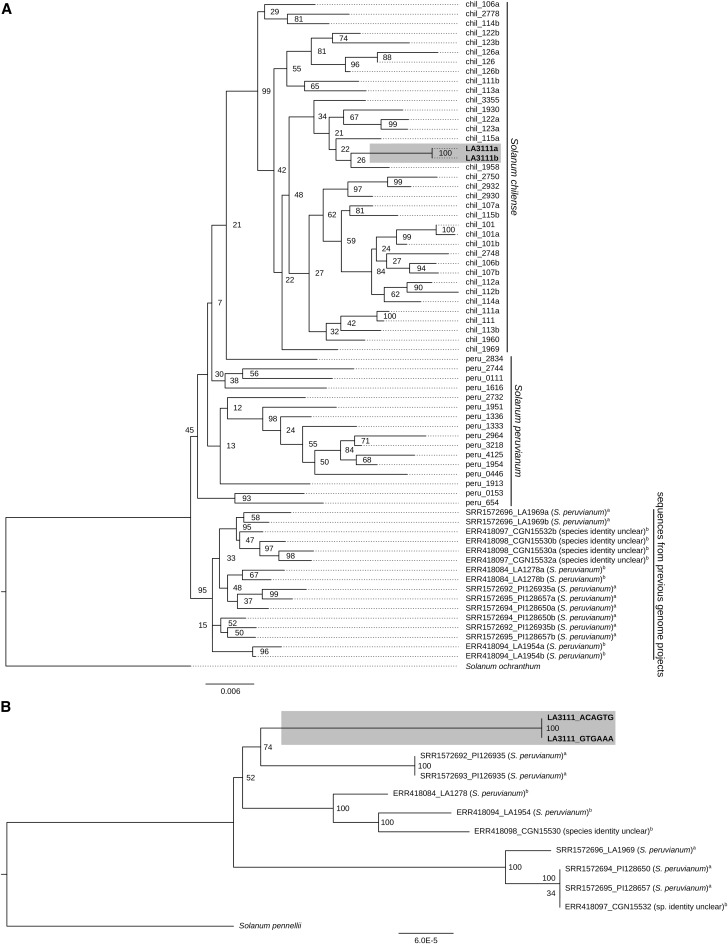
A) Maximum Likelihood (ML) phylogenetic tree constructed based on six CT loci (nuclear genes) extracted from the S. chilense LA3111 sample sequenced in this study (in bold; marked with gray rectangle) and previously sequenced S. peruvianum and S. chilense samples. For the samples from whole genome data, sequences were aligned to the S. pennellii reference genome and the sequence data for the CT loci was extracted. Single-gene alignments were concatenated; the resulting super alignment was used as in input for RaxML to construct the ML tree (1000 bootstrap replicates). The branch length is shown as expected number of substitutions per site and bootstrap values are reported on each tree node. S. ochranthum was used as an outgroup. The sequence IDs containing chil and peru represent Sanger sequences from S. chilense and S. peruvianum individuals, respectively, followed by the accession/ individual number. The sequences with IDs containing SRR- and ERR-numbers followed by the accession number were extracted from previously generated whole genome data. B) Phylogeny constructed based on chloroplast SNP data extracted from S. chilense LA3111 (in bold and marked with gray rectangle) and previously sequenced S. peruvianum whole genome sequence data. Chloroplast sequences were aligned to the S. pennellii reference genome. The tree was built using resulting alignments and PhyML (GTR, NNI, BioNJ, 1000 bootstrap replicates). The branch length is shown as expected number of substitutions per site and bootstrap values are reported on each tree node. aSequences of individuals with IDs containing SRR1572692, SRR1572693, SRR1572694, SRR1572695 and SRR1572696 were obtained from Lin et al. (2014). bSequences with IDs containing ERR418084, ERR418094, ERR418097 and ERR418098 originate from 100 Tomato Genome Sequencing Consortium (2014). Individual SRR1572696 was reported as S. chilense in the main text of the paper (ref) and as S. peruvianum in the supplementary, which contain all original data. The original classification of the sequences with IDs ERR418097 and ERR418098 as S. chilense has been later withdrawn from the CGN database.